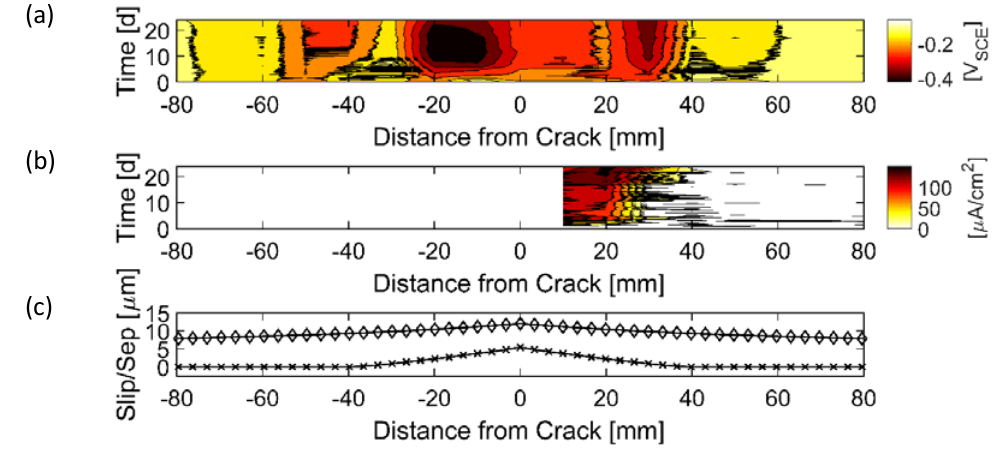
Figure 5 . Location and time ‐ dependent (a) open circuit potential, (b) corrosion current density (bottom), and (c) interfacial damage for specimen with crack width of 0.07 mm. After [39].